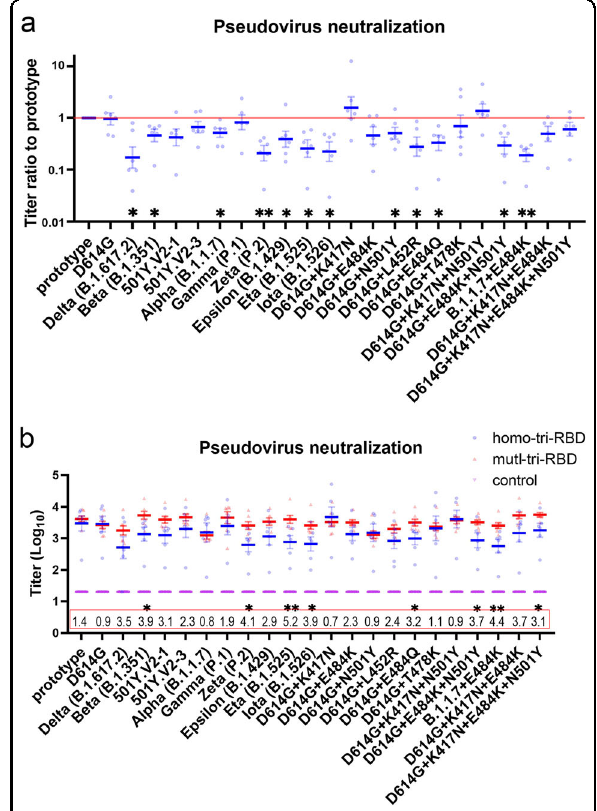
Fig. 4 The neutralizing antibody responses against 23 various SARS-CoV-2 pseudo-virus strains elicited by mutI-tri-RBD were signi fi cantly stronger than or comparable to those induced by homo-tri-RBD. a Sensitivities to the neutralization of homo-tri-RBD immunized sera for the various pseudo-typed variants compared with that of the prototype strain. The sera collected on day 14 post- immunization (D35 in Fig. 2a) were used in the pseudo-virus neutralization assays. In this fi gure, the titers of the prototype strain are taken as a reference, and the titer ratios between the variants and the prototype strain are displayed. Each serum sample is presented as a dot in the plot, and each serum sample was tested against all these variants. Data are presented as means ± SEM. P values were calculated with Student ’ s t test. * P < 0.05, ** P < 0.01. b Neutralizing antibody GMTs against the various pseudo-typed strains induced by mutI-tri- RBD (red color) compared with those elicited by homo-tri-RBD (blue color). Numbers in the red box indicate the GMT ratios of mutI-tri-RBD to homo-tri-RBD. Data are presented as means ± SEM. P values were calculated by using one-way ANOVA followed by Sidak ’ s multiple comparison test. * P < 0.05, ** P <